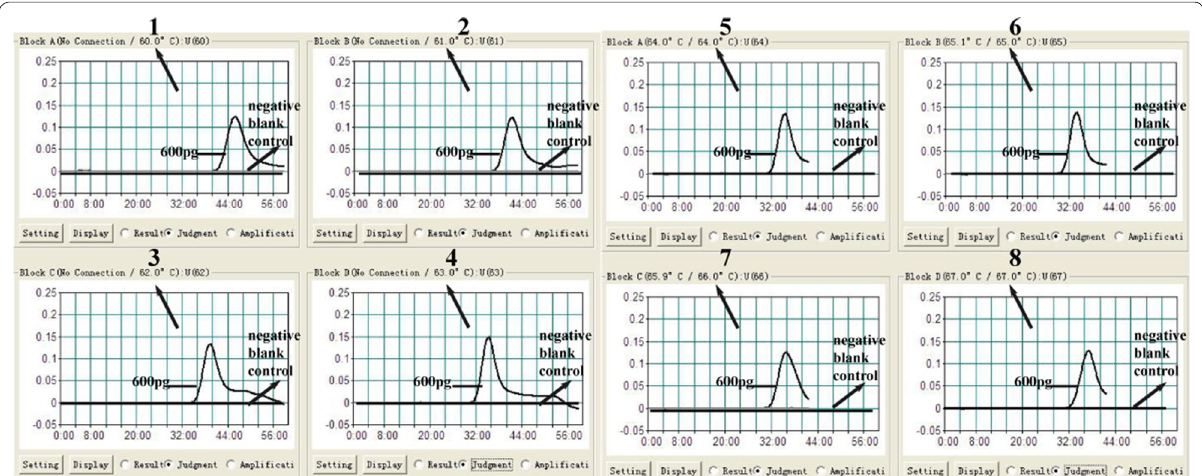
Fig. 3 Optimal reaction temperature of MP-LAMP assay. The amplification products of MP-LAMP assay were monitored by Real-time turbidimeter, and the corresponding curves of each temperature were displayed in the picture. Turbidity of > 0.1 was considered positive. Eight kinetic graphs (1–8) were acquired at different temperatures ranging from 60 to 67 °C with the concentration of DNA templates of MP at the level of 600